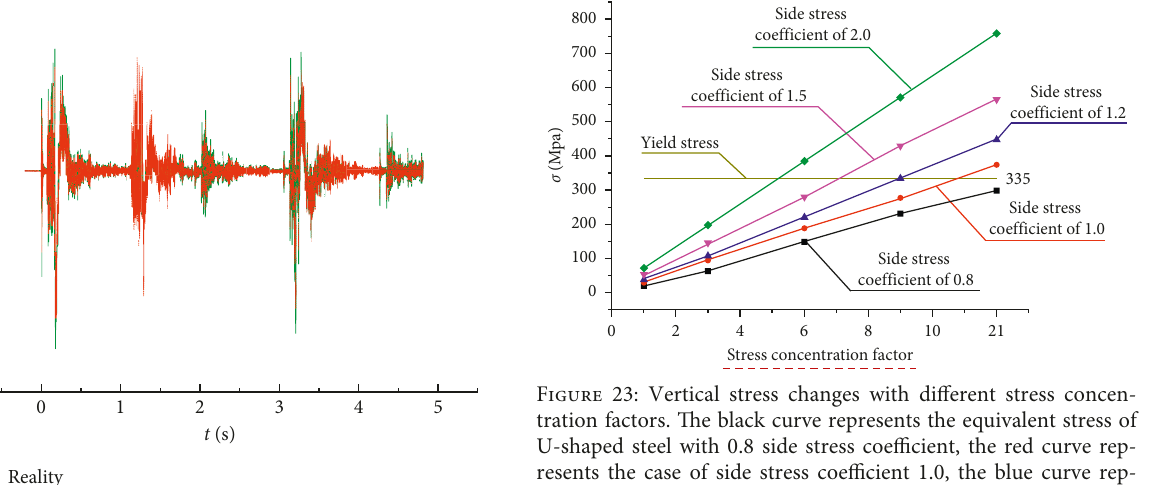
Figure 21: The 630m middle ramp. The red circle in the diagram shows the degree of adhesion between U-shaped steel and surrounding rock. The average spacing of U-shaped steel is 1.5m, and the contact area ratio is approximately 1/4. −